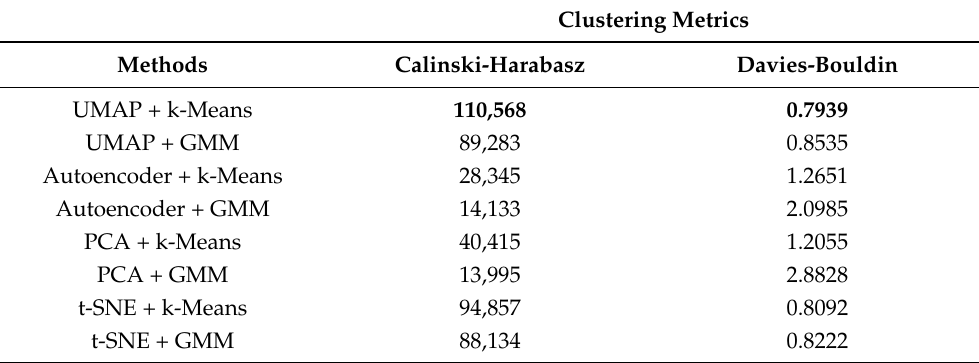
Table A1. Mean of the Calinski-Harabasz and Davies-Bouldin criterion over a range of 5 to 20 clusters for the FRT0000c564 dataset, split by method. The best score for each coefficient is in bold.